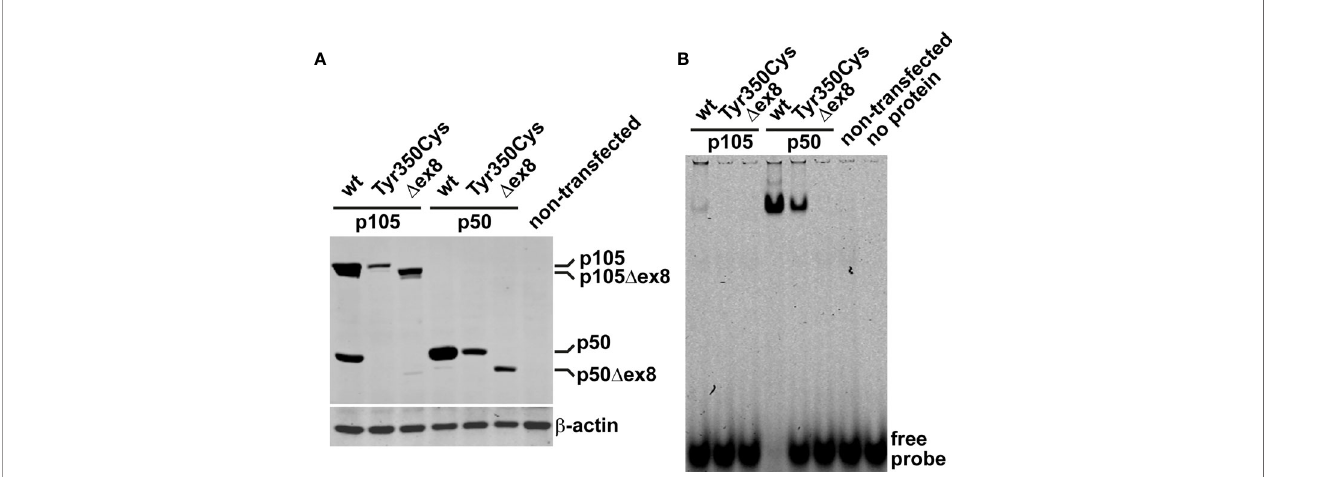
FIGURE 3 | The missense variant p.Tyr350Cys causes decay of the p105 precursor but does not prevent p50 nuclear translocation and DNA-binding. (A) HEK293T cells were transiently transfected with EGFP-fusion constructs of wildtype or variant p105 or p50 (300 ng each per well on 48-well plates). The variant cDNAs carry either the Tyr350Cys missense change or the internal deletion D ex8, as indicated. Whole cell lysates were prepared 40 hours after transfection and analyzed by Western blotting for expression and processing of EGFP-p105 and expression of EGFP-p50, respectively, using an antibody directed against both p105 and p50. In transfected cells, a proportion of the ectopic wildtype p105 is converted to p50 by endogenous mechanisms. In contrast, p105-Tyr350Cys only gains moderate expression levels and processing to p50-Tyr350Cys is almost undetectable, resembling the internal deletion variant p105 D ex8. Only limited expression of either of the variant p50 forms is obtained, unlike their wildtype counterpart. An anti- b -actin antibody was used to con fi rm equal loading. A representative example of at least eight experiments is shown. Similar results were obtained using various DNA amounts (100-300ng per well). Supplementary Figure 2 shows an analogous experiment using non-fused constructs. (B) Nuclear proteins were isolated from transiently transfected HEK293T cells (300ng of the fusion constructs per well on 48-well plates; 48 hours) and NF- k B-DNA- binding was determined by EMSA. DNA-binding activity originating from processing of the p105 precursor to p50 is only detectable upon ectopic expression of wildtype p105 but not upon transfection of the p105-Tyr350Cys missense variant or the p105 D ex8 variant. Transfection of p50-Tyr350Cys produces substantially less DNA- binding activity compared to wildtype p50, which is probably due to lower expression. In-frame skipping of exon 8, deletes a part of the Rel-homology domain and abrogates DNA-binding in the p50 D ex8 variant. Representative results of at least four independent experiments are